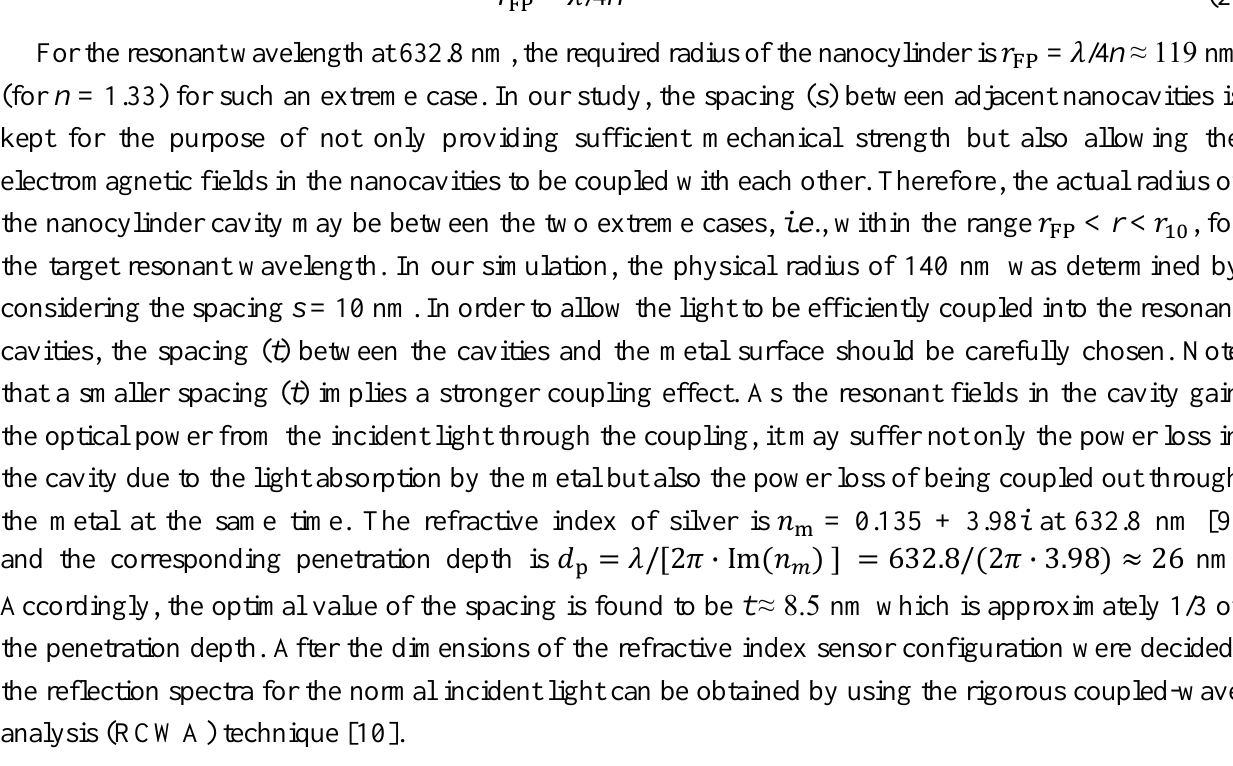
Figure 1. Schematic of the proposed sensor configuration based on the nanocavity resonators in